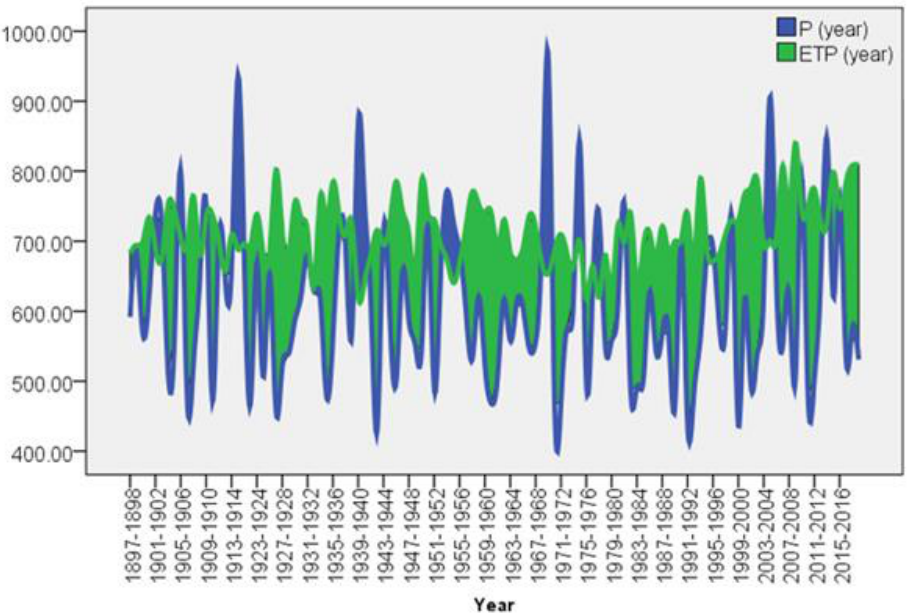
Figure 15. High – Low chart by difference area between the cumulative values throughout the year, of precipitation (P year) and evapotranspiration (ETP year), expressed in mm, registered annually at the Regional Meteorological Center Banat-Crisana, Romania, 1898-2019.